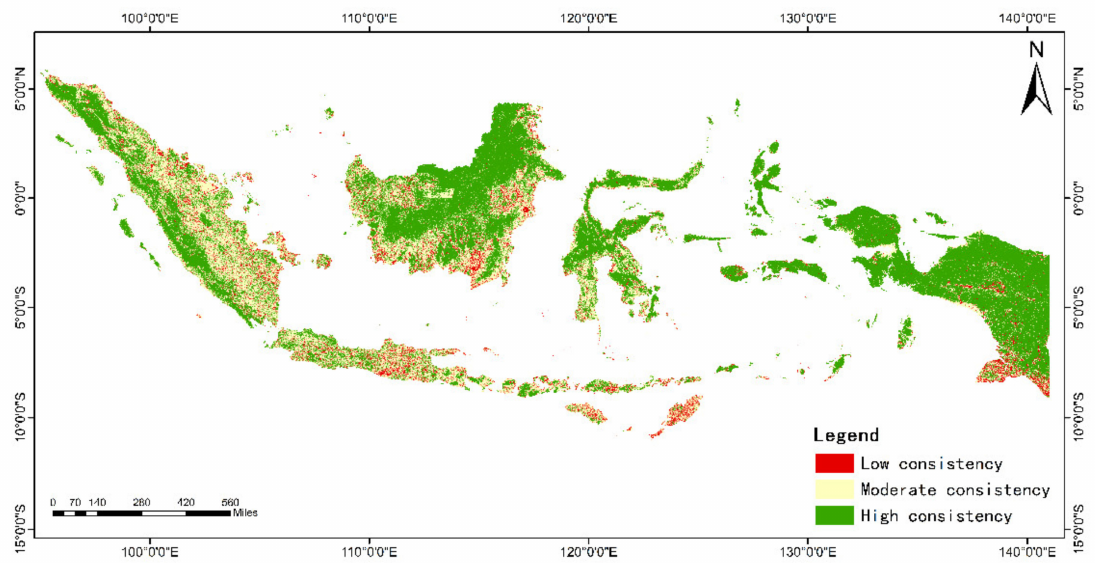
Figure 8. Spatial consistency distributions of all land cover types in the study area.